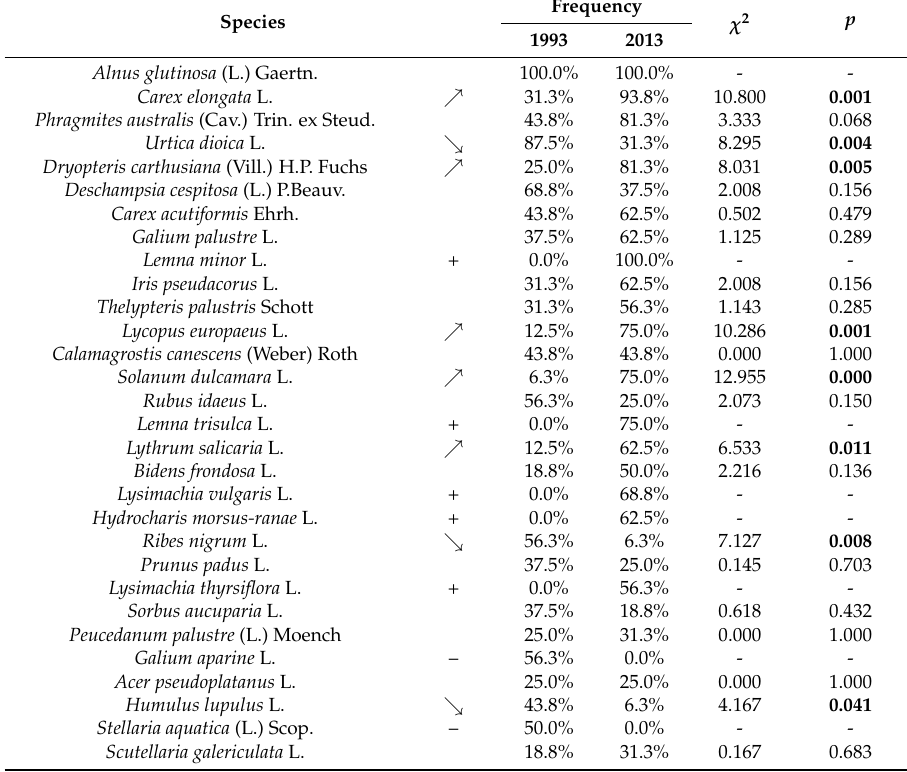
Table 4. List of plant species that formed whole dataset (32 samples) with frequency higher than 25%. Species χ